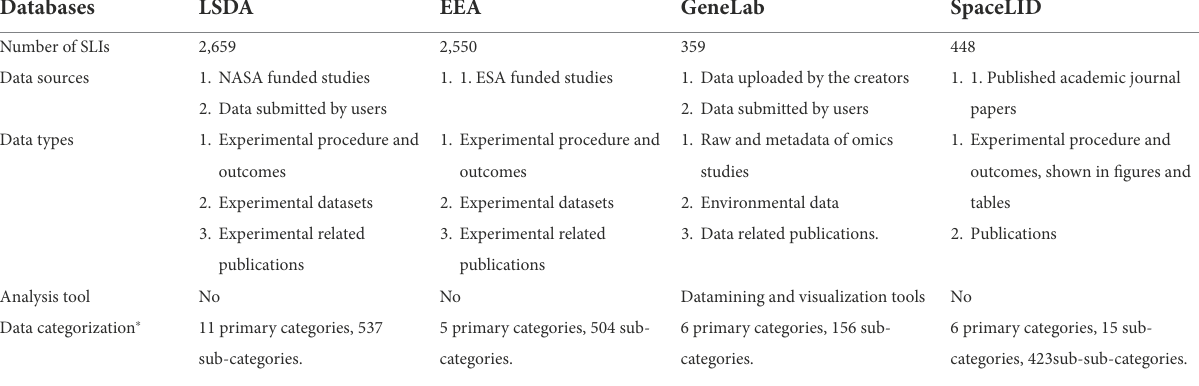
TABLE 1 Comparison of SpaceLID and established space life science